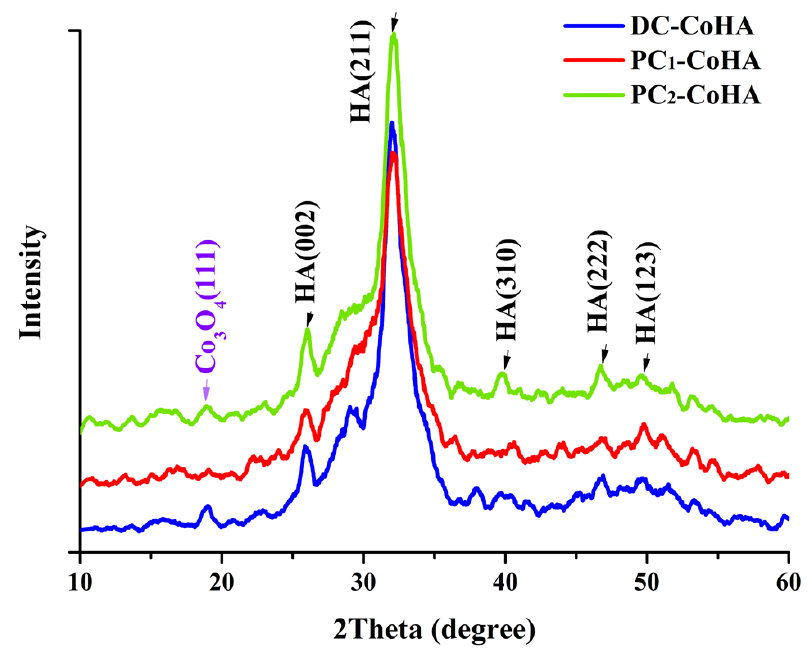
Figure 4. XRD patterns of the CoHA samples synthesized with different power supply. Table 3. Element ratios inside CoHA particles and ion release concentration in CoHA